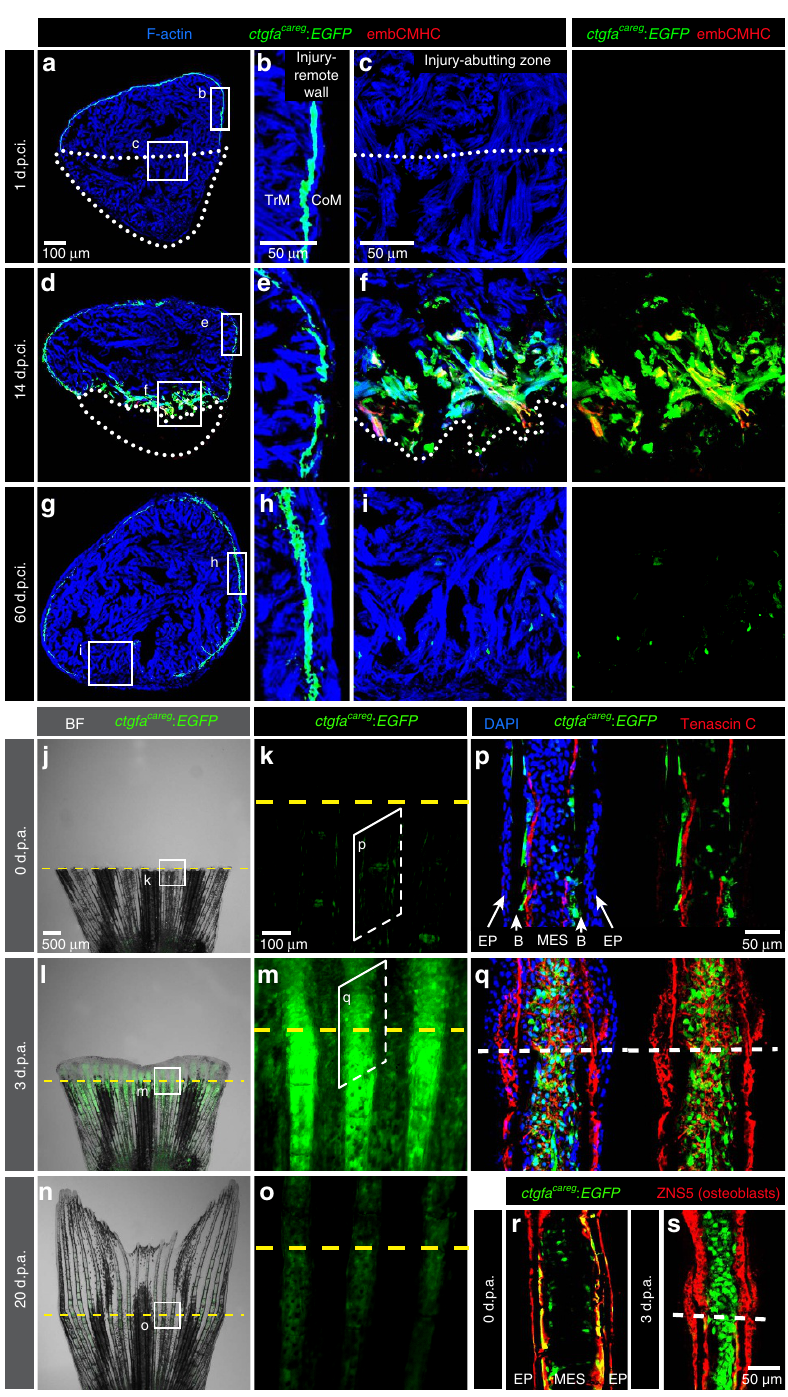
Figure 1 | A transgenic reporter of the peri-injured myocardium and the fin stump. ( a – i ) Transversal ventricle sections of transgenic fish ctgfa careg :EGFP immunostained for embCMHC (red) at different days post-cryoinjury (d.p.ci.). The cardiac muscle is detected by F-actin staining (Phalloidin, blue). ( b , e , h ) The injury-remote part of the ventricular wall displays a subcortical layer of ctgfa careg :EGFP cells that is located between the thin cortical myocardium (CoM) and the inner trabecular myocardium (TrM). This layer does not express embCMHC and remains unaltered during regeneration. ( c , f , i ) The injury- abutting zone of the ventricular wall shows transient expression of ctgfa careg :EGFP and embCMHC within a distance of 100 m m from the wound border during regeneration. N Z 4. ( j – o ) Live-imaging of fins at different days post amputation (d.p.a.). Bright-field (BF) was combined with fluorescence. ( k , m , o ) Higher magnifications of the region at the amputation plane (yellow dashed line) show transient expression of ctgfa careg :EGFP in the stump and the regenerate. N ¼ 4. ( p – s ) Immunofluorescence staining of longitudinal fin sections. ( p , r ) At 0 d.p.a., ctgfa careg :EGFP þ cells are associated with Tenascin C fibres along the border between the bones (B) and mesenchymal cells (MES), but not the epidermis (EP). Some of these cells express an osteoblast marker visualized with Zns5 antibody (red). ( q , s ) At 3 d.p.a., Tenascin C demarcates the zone of tissue remodelling in the stump and the outgrowth. ctgfa careg :EGFP is upregulated in the activated MES at the peri-injury zone, but not in Zns5-labelled osteoblasts of the outgrowth. N Z 4. Post-infarcted ventricle is encircled with a dotted line. Fin amputation plane is shown with a dashed line. The same rules apply to all subsequent